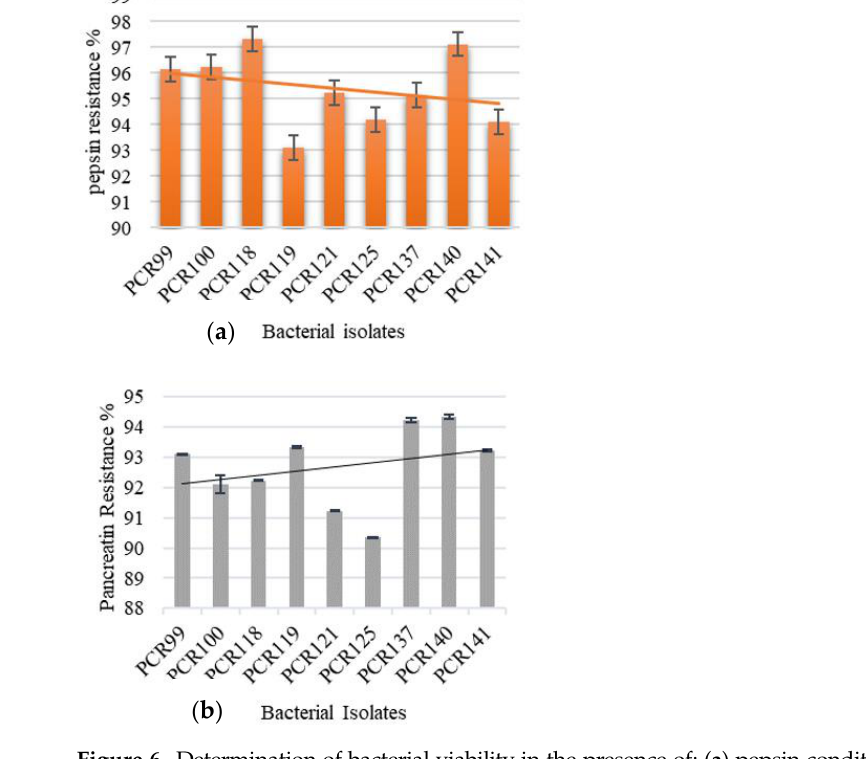
Figure 6. Determination of bacterial viability in the presence of; ( a ) pepsin conditions and ( b ) pancreatin conditions.